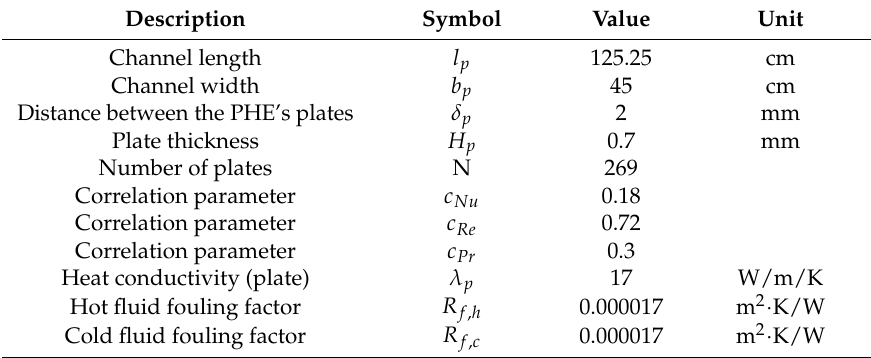
Figure 3. HISAKA PHE in the district heating system. Table 1. Parameter of the plate heat exchanger